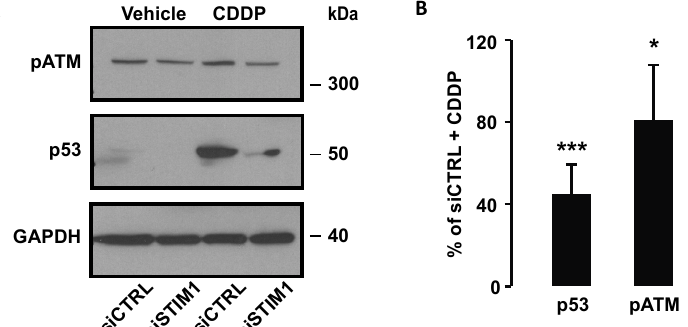
Figure 6. Effect of STIM1 depletion on CDDP-induced DDR. ( A ) Immunoblot analysis showing the effect of 24 h treatment with 25 µ M CDDP on pATM and p53 level in siCTRL or siSTIM1 transfected cells. One immunoblot representative of at least three independent experiments. ( B ) Quantification of experiments presented in A . Results are expressed as means ± S.D. ( n ≥ 3). Student’s t test was employed to assess statistical significance. * p < 0.05; *** p < 0.001.